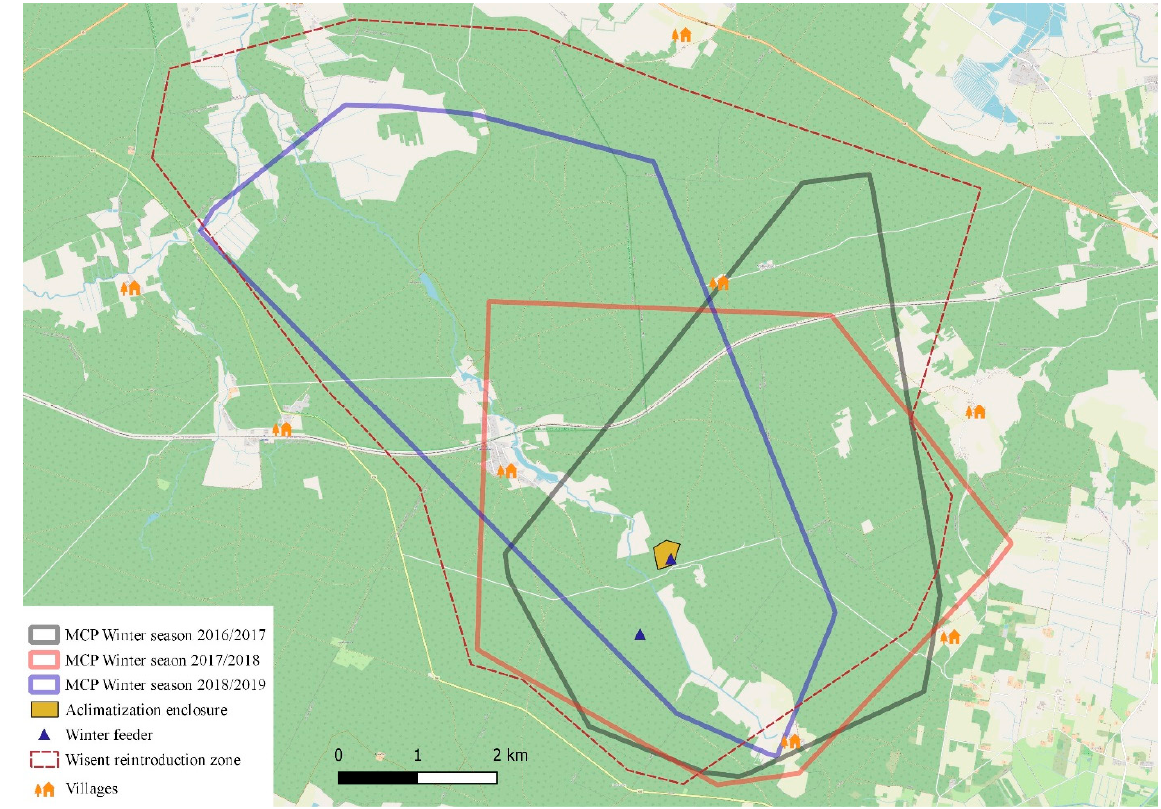
Figure 6. Minimal convex polygon areas during winter seasons .